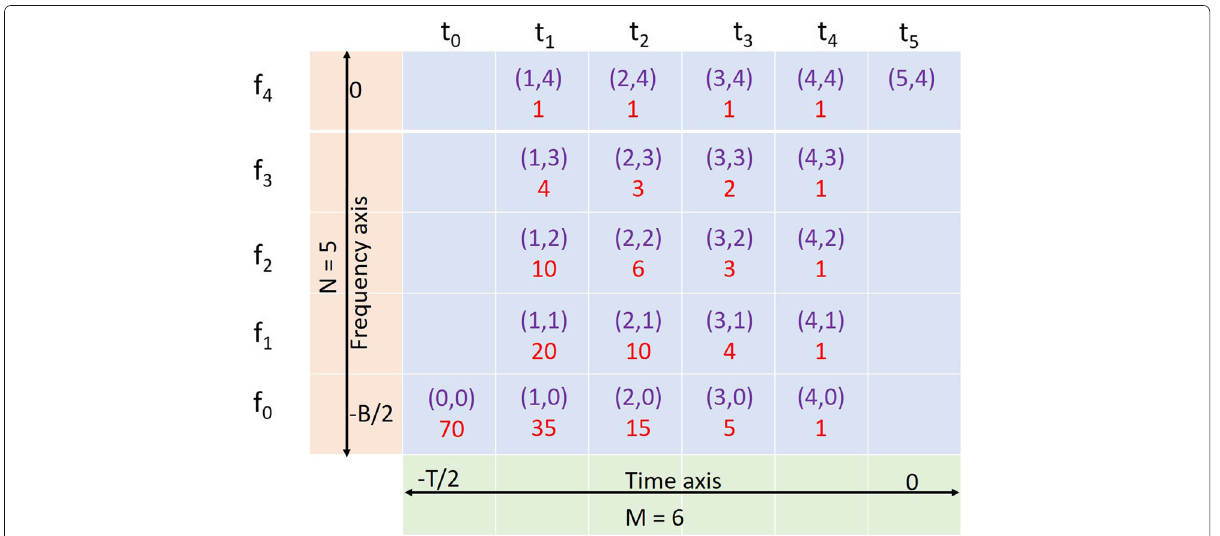
Fig. 6 All possible monotonically increasing frequency functions with six discrete time values and five discrete frequency values. Number of possible frequency paths for the given (time, frequency) combination is given by the number written below in red font. All frequency paths start at (0,0) and ends at (5,4)